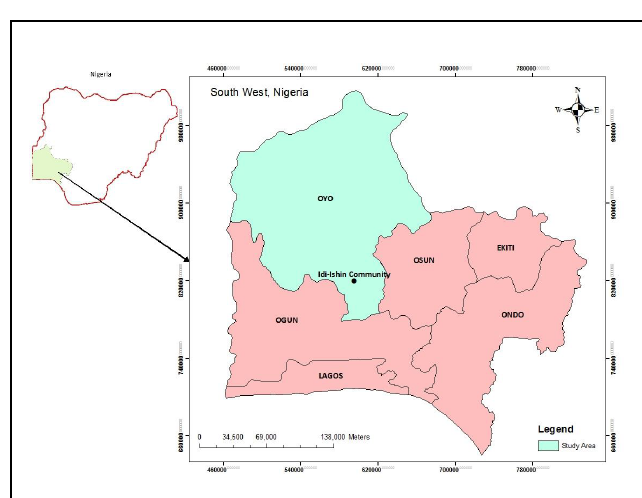
Figure 1. Location of the Study Area